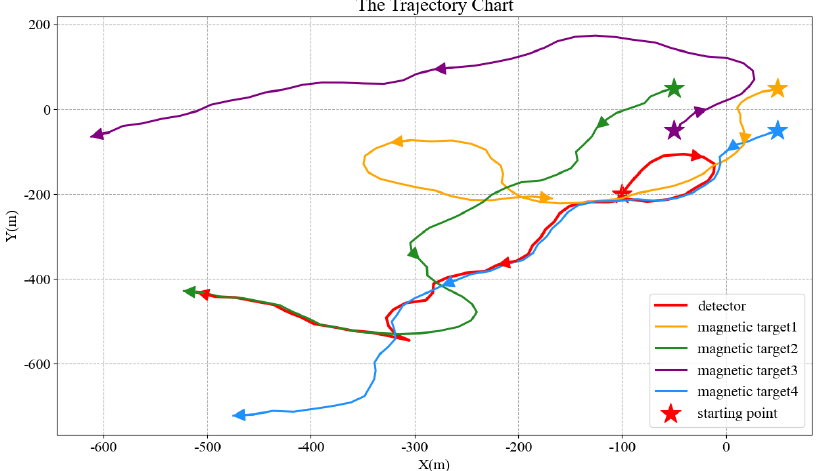
Figure 3. Real − time motion tracking of multiple magnetic targets, in which the motion tracking time t = 50 s, and the sampling interval t 0 = 1 s.